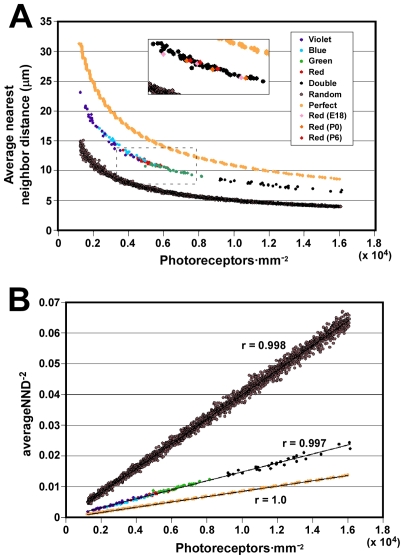
All cone types measure intercone distance with the same yardstick.(A) Graph of photoreceptor density vs. average nearest neighbor distance for all 140 P15 cone mosaics examined (middle curve). The upper and lower curves are graphs of density vs. average nearest neighbor distance for a series of computer-generated perfect and random distributions, respectively. The inset shows data for the three developmental timepoints (i.e., red cones at E18, P0 and P6). It corresponds to the region of the main graph highlighted with a dotted box except that all P15 chicken datapoints shown in the main graph are shown in black to facilitate visualization of the developmental timepoints. (B) Graph of the same datapoints as in (A) but shown as density vs. the inverse-square of the average nearest neighbor distance. The linear correlation coefficients (r) for the best fit line for each of the three datasets are shown.